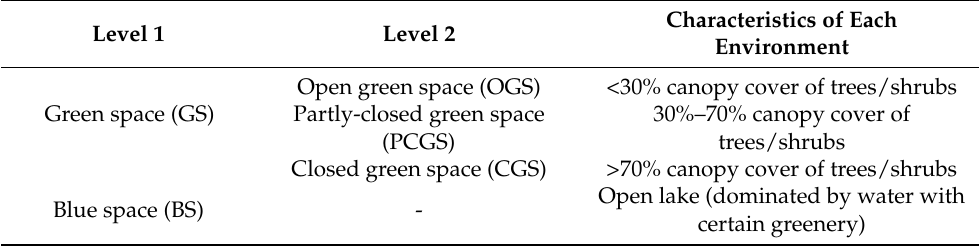
Table 2. Classification of urban natural